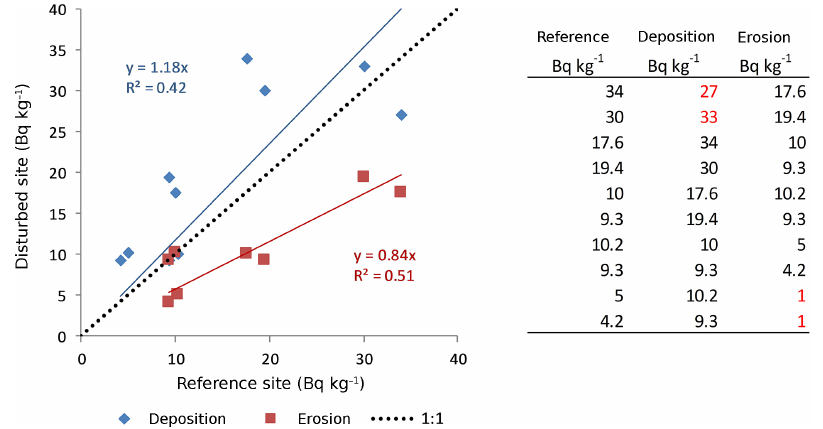
Figure 3. Hypothetical signs of sheet erosion (red) and deposition (blue) on a depth profile compared to an undisturbed